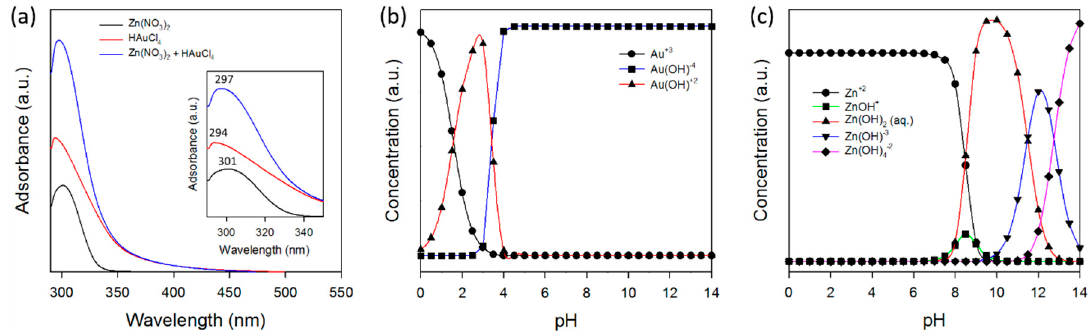
Figure 6. ( a ) UV-Vis spectra of Zn(NO 3 ) 2 and HAuCl 4 solutions as precursors. Speciation diagram of ( b ) HAuCl 4 and ( c ) Zn(NO 3 ) 2 precursors in solution with pH.